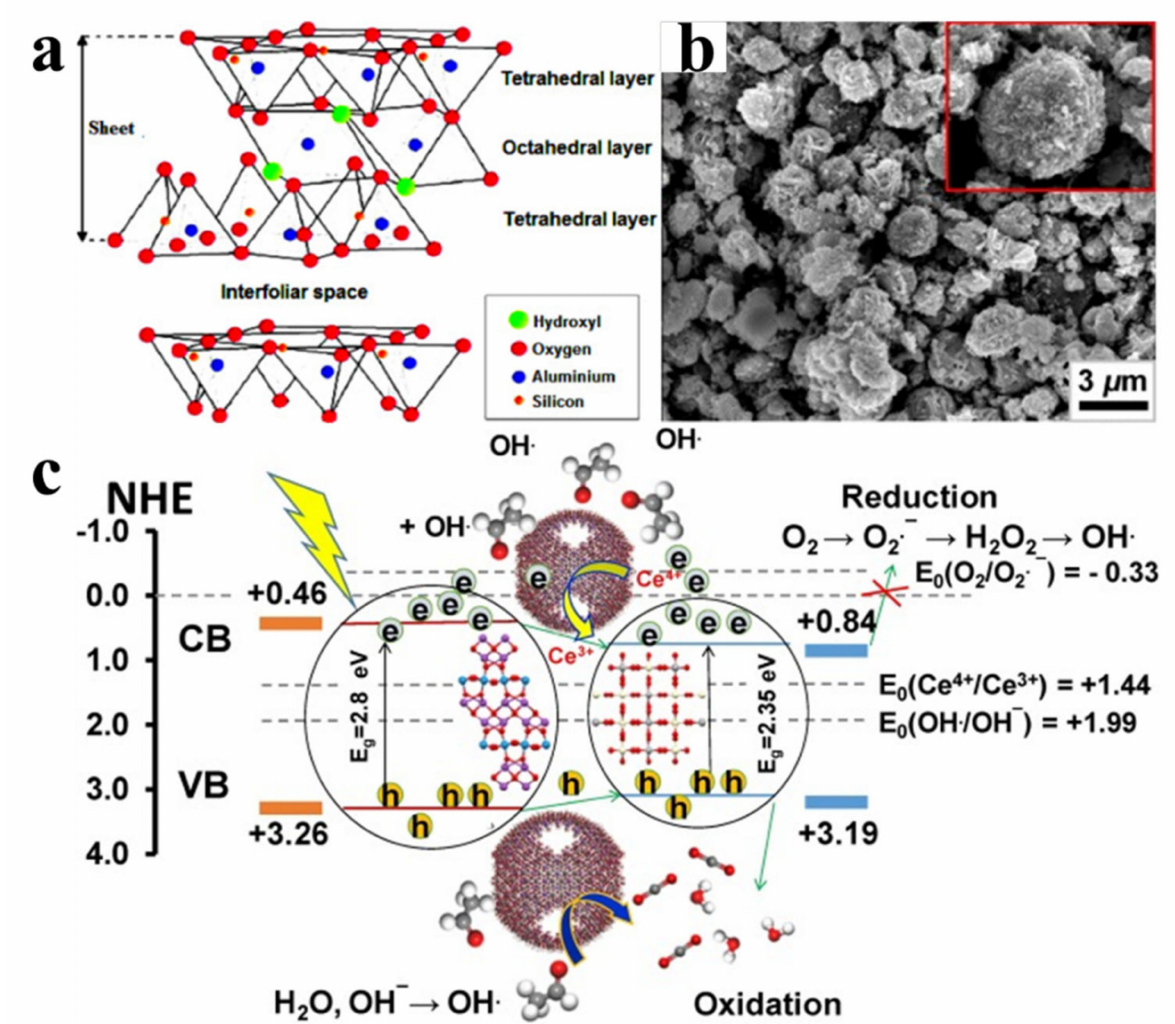
Figure 9. ( a ) Structure of pyrophyllite; ( b ) SEM images of the Bi 2 WO 6 /CeVO 4 /allophane composite photocatalysts synthesized with 1:3 of Bi 2 WO 6 :CeVO 4 ; ( c ) schematic representation of the possible mechanisms of acetaldehyde photodegradation over the Bi 2 WO 6 /CeVO 4 /allophane composite under visible − light irradiation. Adapted with permission from Ref. [51]. Copyright 2018, Elsevier B.V; Adapted with permission from Ref. [208]. Copyright 2017, Elsevier